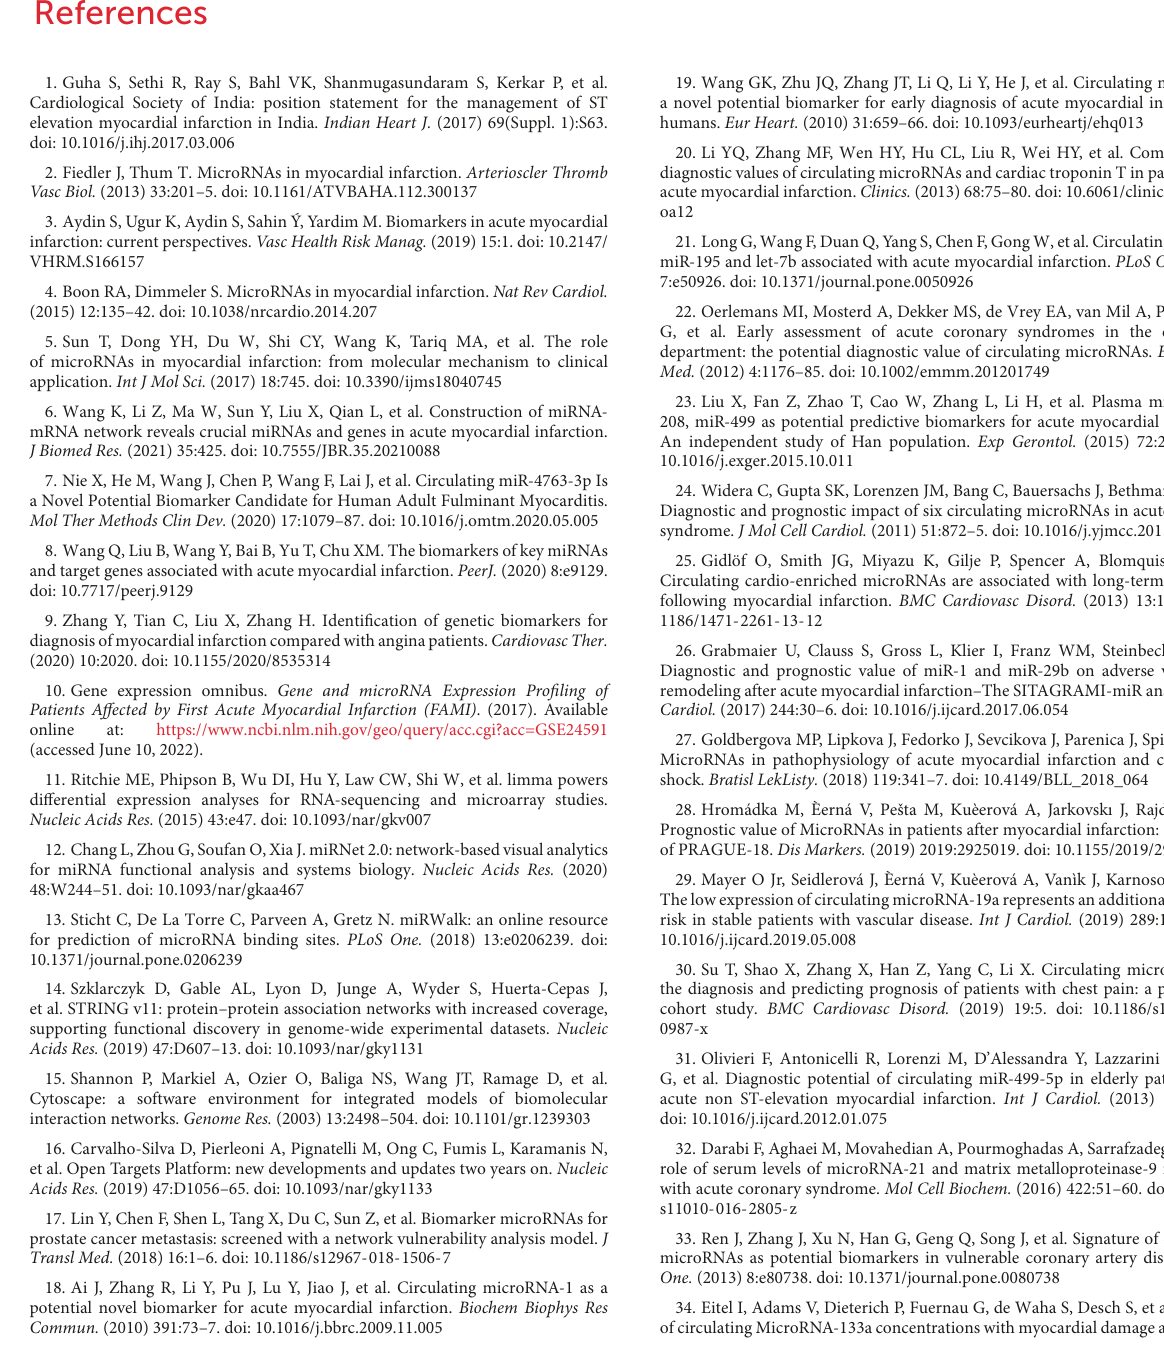
obtained using TargetScan Human 7.2 database. SUPPLEMENTARYFIGURE3 Flow chart illustrating the summary protocol and findings of in silico analysis using bioinformatics tools. “ ∗ ” Denotes 25 miRs obtained from GSE148153 and GSE24591 datasets only; “#” denotes partial list of the vital functions/pathways involved in myocardial